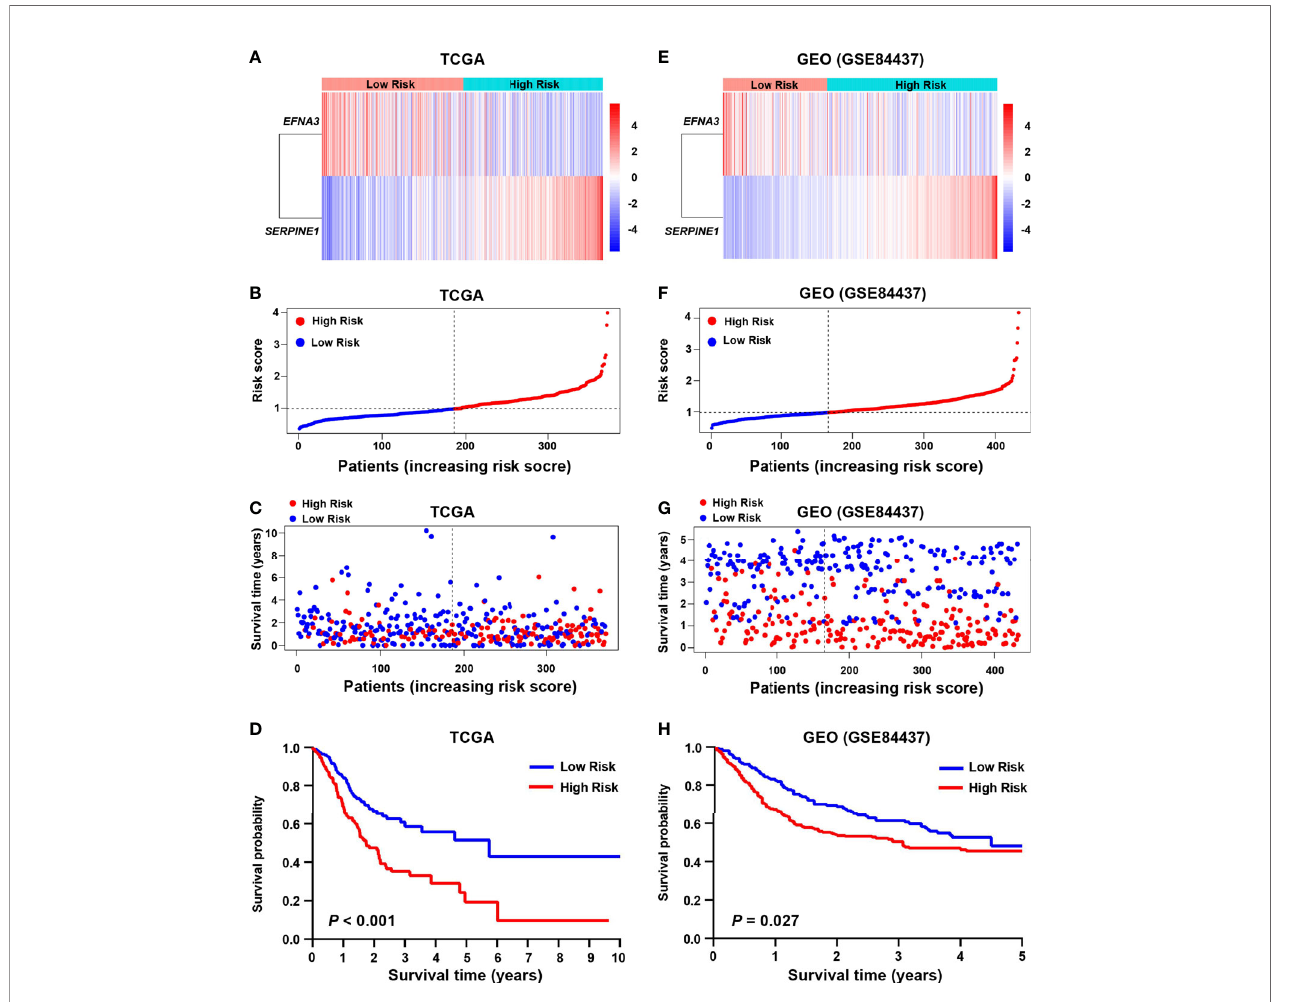
FIGURE 2 | Prognostic value of the hypoxia risk signature in gastric cancer. (A, E) Heatmaps of the prognostic signature in the screening (TCGA) and validation (GEO) cohorts. (B, F) Patient risk score in the screening and validation cohorts. (C, G) The status distribution of patients in the high-risk and low-risk groups in the screening and validation cohort. (D, H) Kaplan-Meier analysis of patients in the high-risk and low-risk groups in the screening and validation